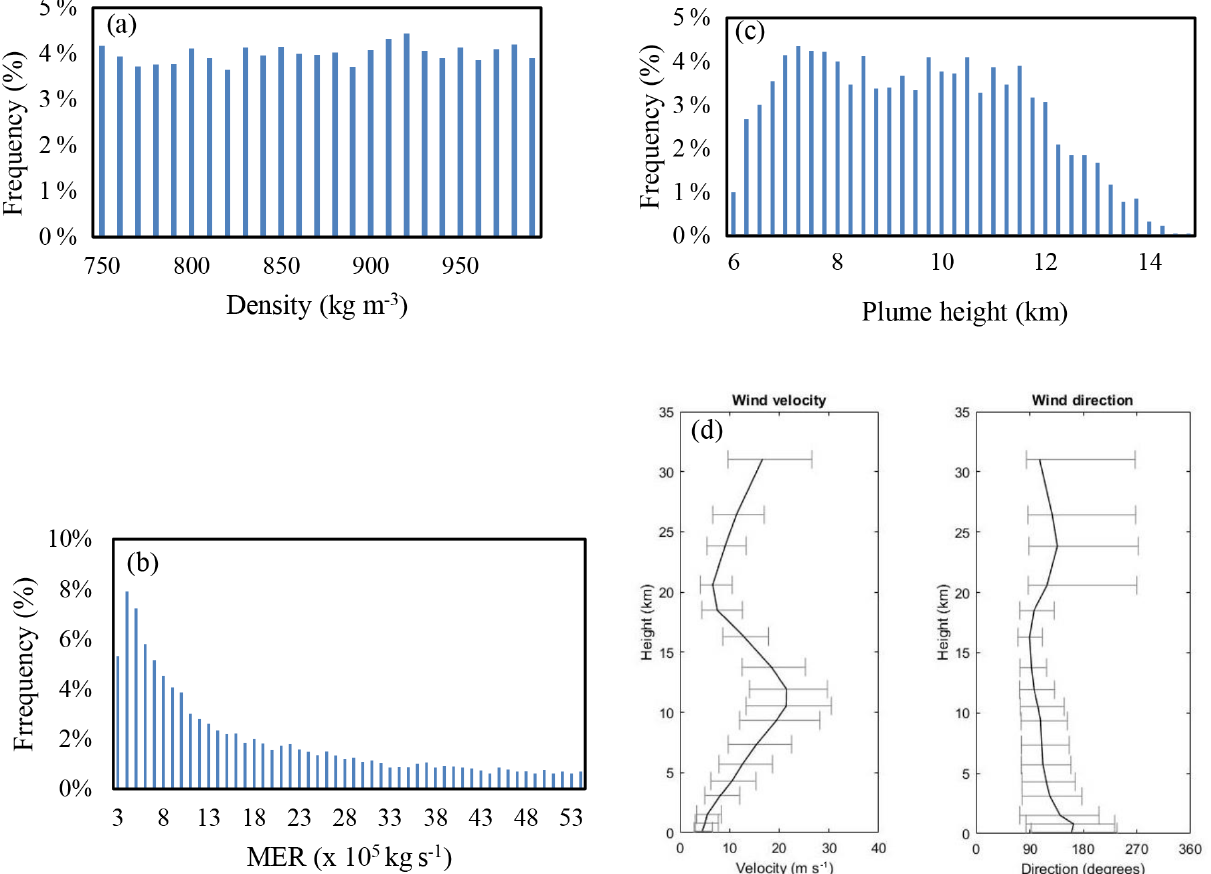
Figure C1. Parameters sampled for the ERS. (a) Particle density, (b) mass eruption rate, (c) plume height, (d) wind speed and direction (created in TephraProb) (Biass et al., 2016c; NOAA, 2017). Plume height depends on mass eruption rate and wind speed. Wind direction is the direction towards which the wind blows, which is indicated in degrees from